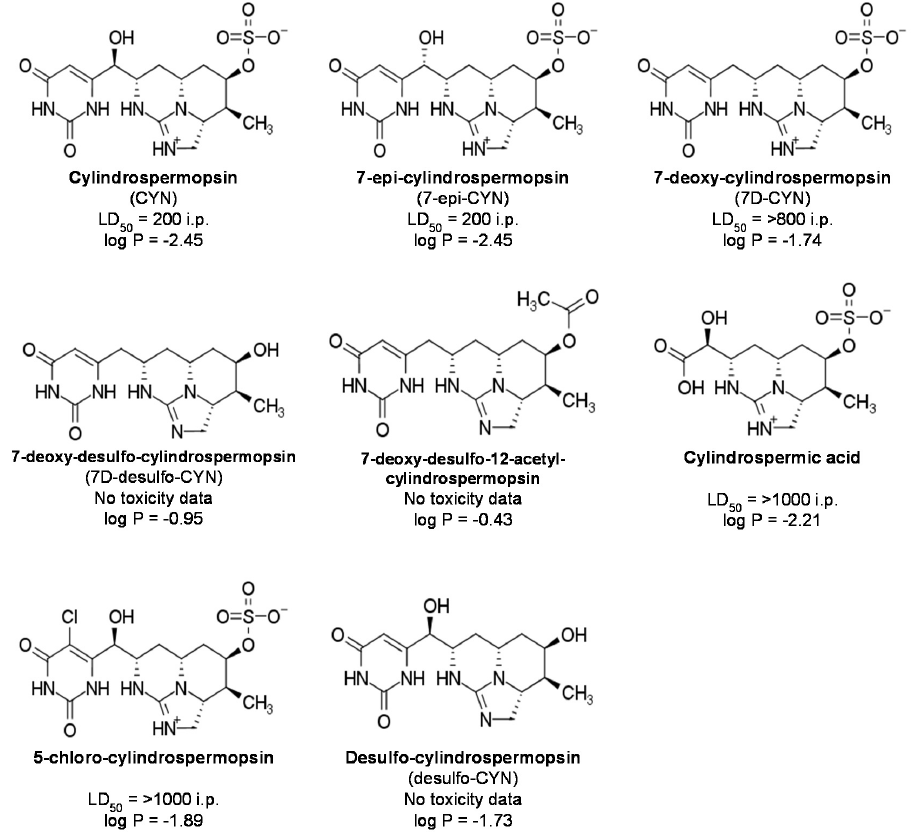
Figure 1. Structure, toxicity and theoretical log P of natural cyanotoxin cylindrospermopsin (CYN) alkaloids and degradation products. LD 50 (µg/kg) refers to the median lethal dose in mice, administered by intraperitoneal (i.p.) injection. Theoretical log P corresponds to the arithmetic mean of the values calculated by online cheminformatics tools (see Table S1 for details) [7–10]. Cylindrospermopsins (CYNs) are structural analogs of the originally reported CYN molecule.